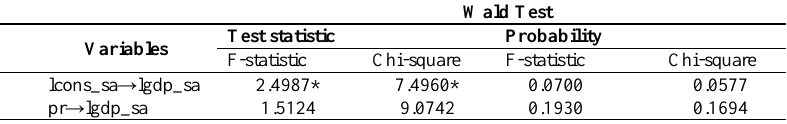
Table 4. Short-run Granger